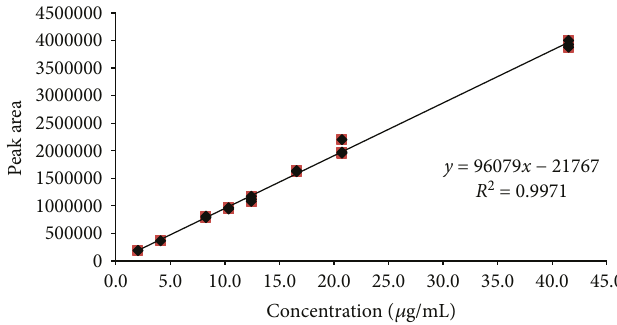
Figure 7: Linearity determination of ketorolac in wastewater.